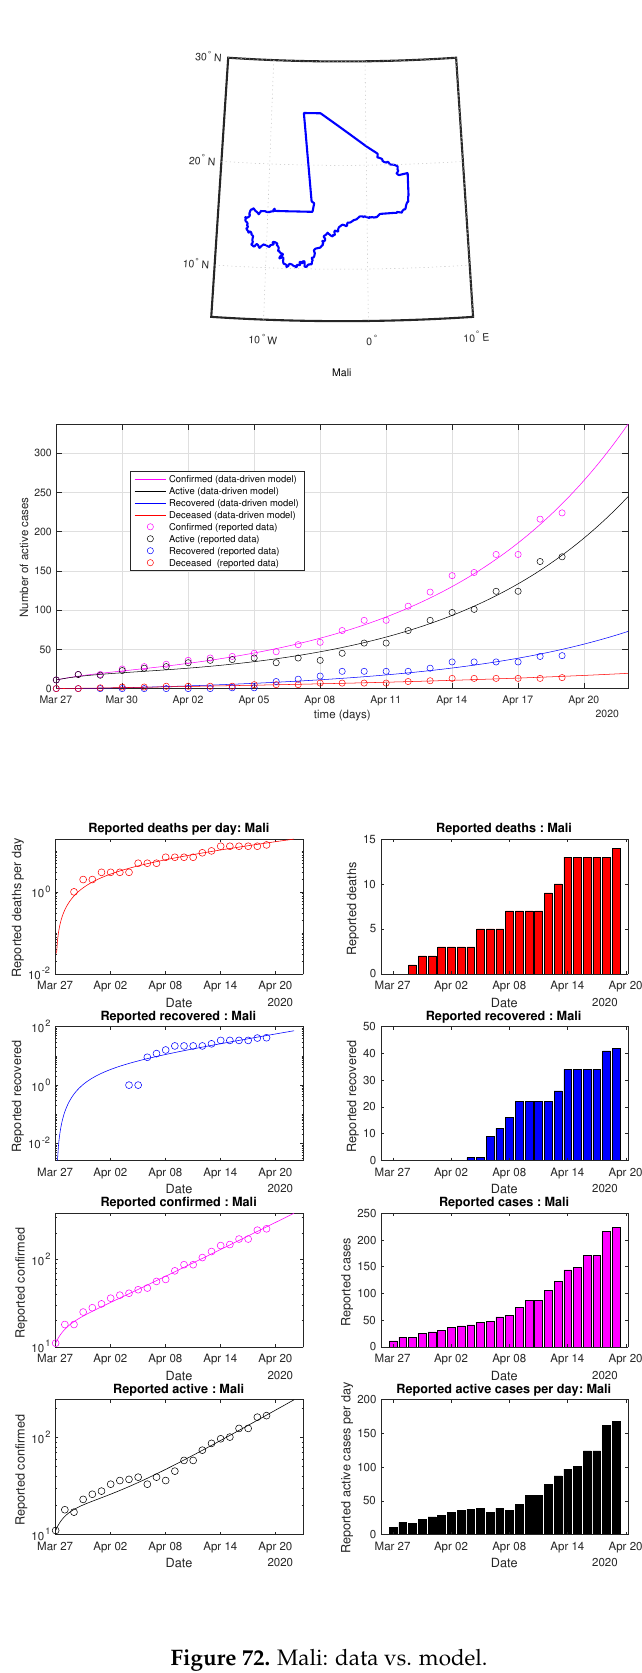
Figure 72. Mali: data vs.